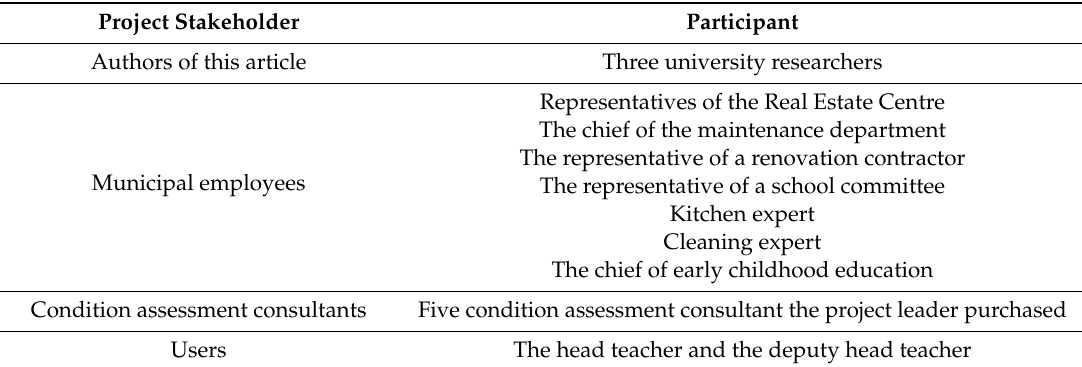
Table 2. The participants of the